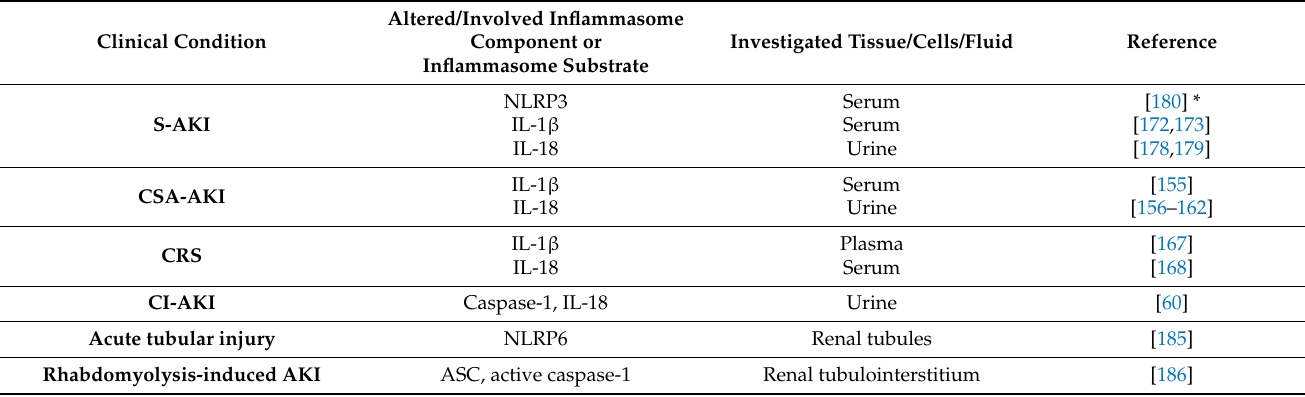
Table 3. Inflammasome component involvement in human AKI.